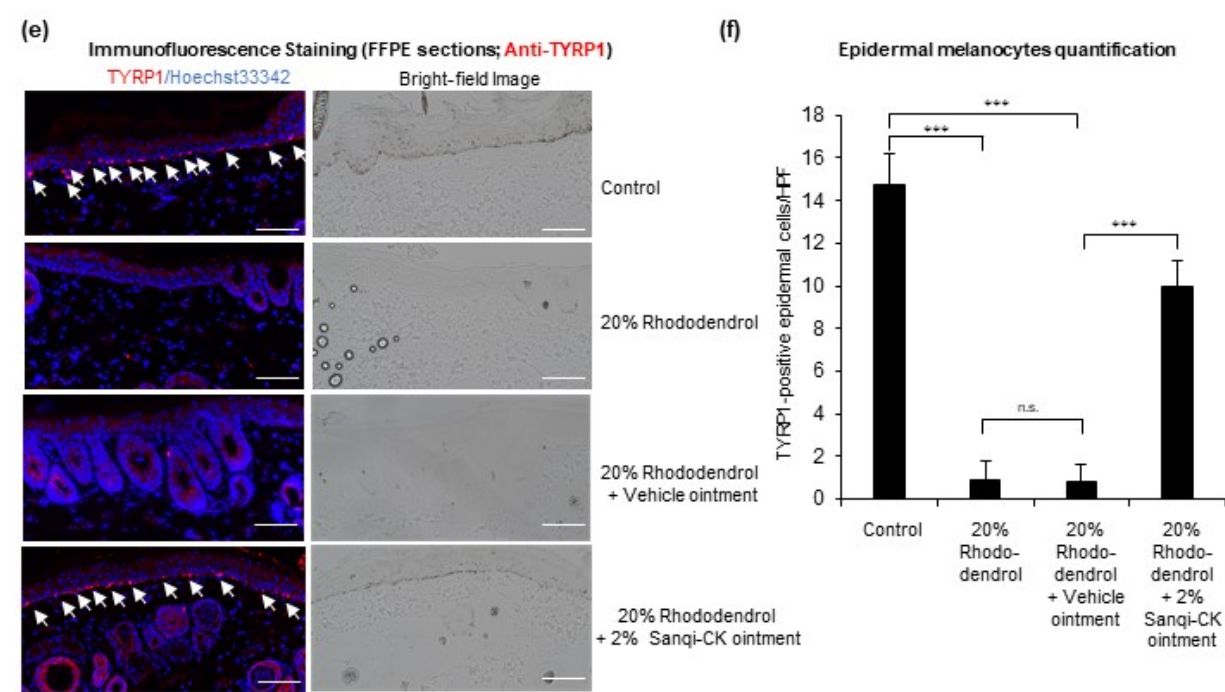
Figure 6. Effects of Sanqi-CK ointment in a rhododendrol-induced leukoderma guinea pig model. ( a ) Experimental schedule; ( b ) macroscopic appearance of skin color; ( c ) L* value of skin color in the indicated treatment groups; ( d ) Fontana-Masson staining of skin sections in the indicated treatment groups, with melanin appearing black; and ( e ) melanocytes stained with anti-TYRP1 antibody (in red) and nuclei stained with Hoechst 33342 (in blue), with bright-field images shown in the lower panel. White arrows indicate TYRP1-positive epidermal melanocytes. The red signal outside the skin is from keratin autofluorescence. Representative images of three independent experiments performed are shown in ( b , d , e ). White bar in ( d , e ), 100 µ m; ( f ) TYRP1-positive epidermal melanocytes were counted in 10 non-contiguous random grids under high-power magnification fields (HPF, 200 × ) by confocal microscopy. The number of epidermal melanocytes per 10 hyper-power microscopic fields is shown in the histogram. Data in ( c , f ) are shown as mean ± SD. n.s., no significant difference; *** p < 0.01; difference between the indicated two groups by Student’s t